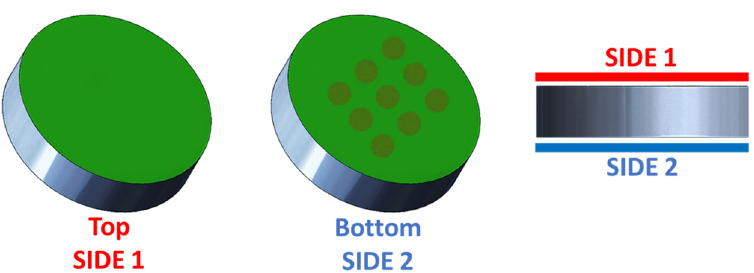
Figure 2. The division of ZnO ceramics turning operations to two sides, illustrative of uniaxial pressing of green compacts prior to sintering operation.